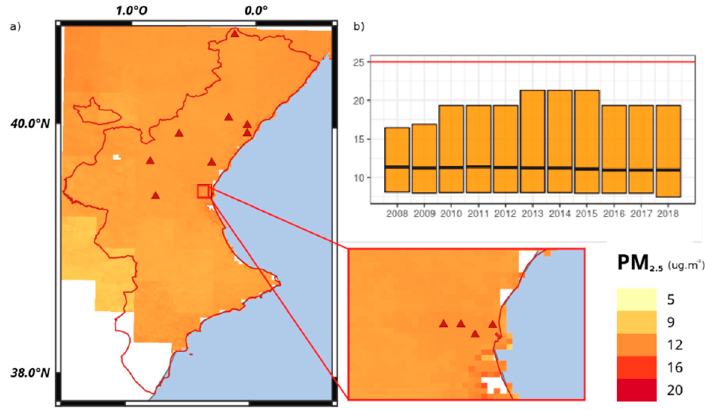
Figure 2. ( a ) Example of average PM 2.5 concentrations map in 2008 for the Valencian Community and the city of Valencia. ( b ) Range of annual mean concentrations modelled for the Valencia Community